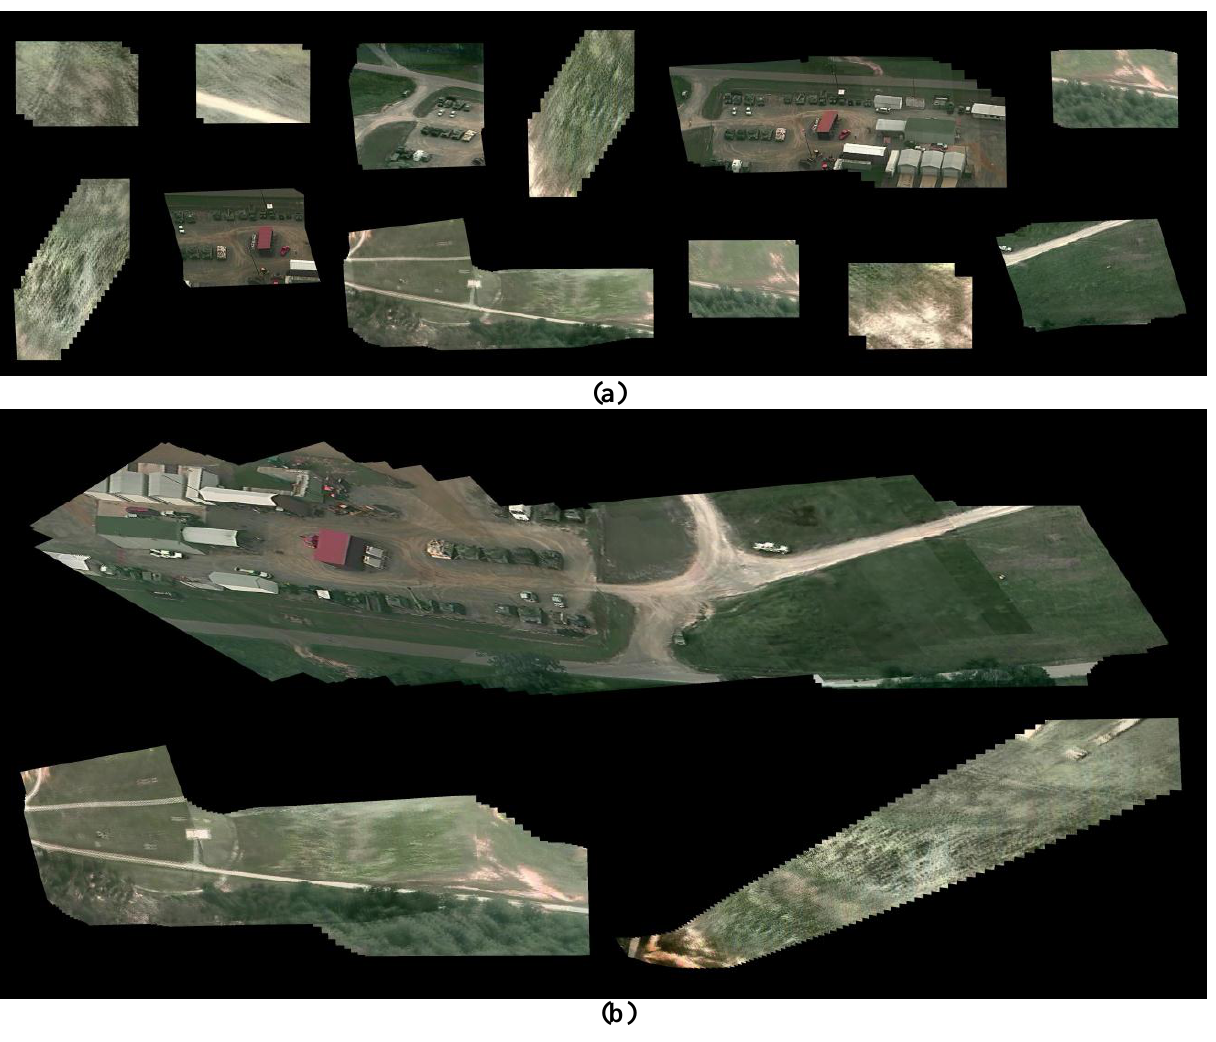
Figure 4. Example of retrieval stitching vs . hybrid stitching. ( a ) Retrieval stitching results with 12 panorama patches from 3 scenes. ( b ) Our hybrid stitching results with complete panorama of 3 scenes.